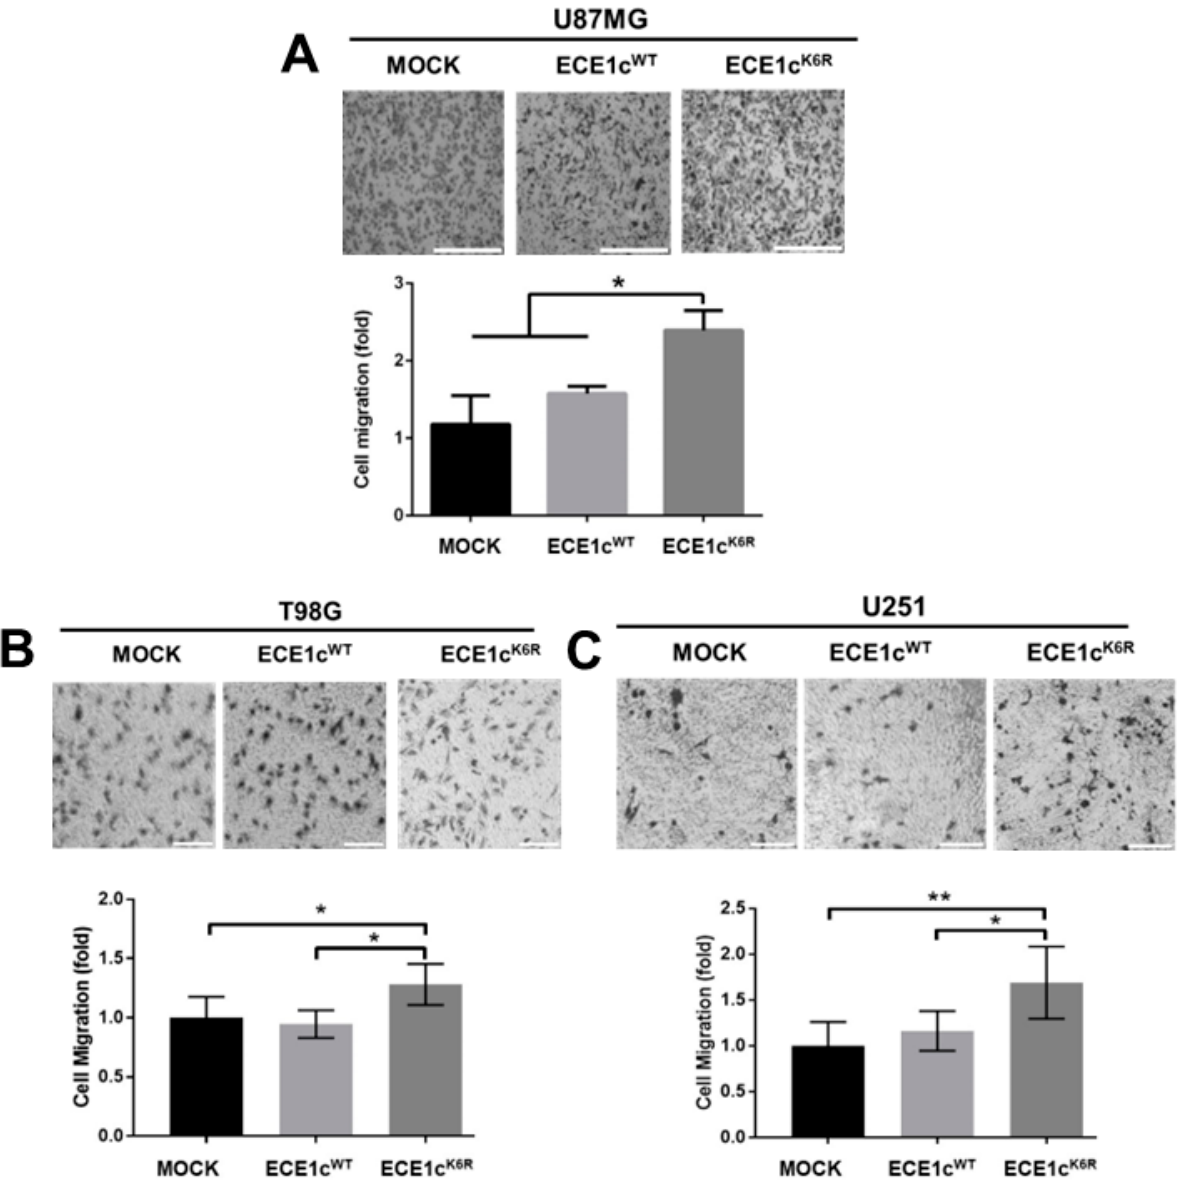
Figure 6. Migration was improved in ECE1c K6R -expressing GBM cells. Three-dimensional cell migration was evaluated in mock, ECE1c WT -expressing, and ECE1c K6R -expressing U87MG ( A ), T98G ( B ), and U251 ( C ) cells grown in normal conditions using a transwell assay, with 10% FBS as a chemoattractant. Cells were incubated at 37 °C for 2 h, and cell that migrated were fixed and stained with crystal violet. Cells were counted using the 4x objective in 5 different fields, mock normalized to 1, and plotted as fold changes. Scale bar: 100 nm. Data represent averages ± SEMs ( n = 3). Peritz F and Student’s tests were used. * p ≤ 0.05, ** p ≤ 0.01.